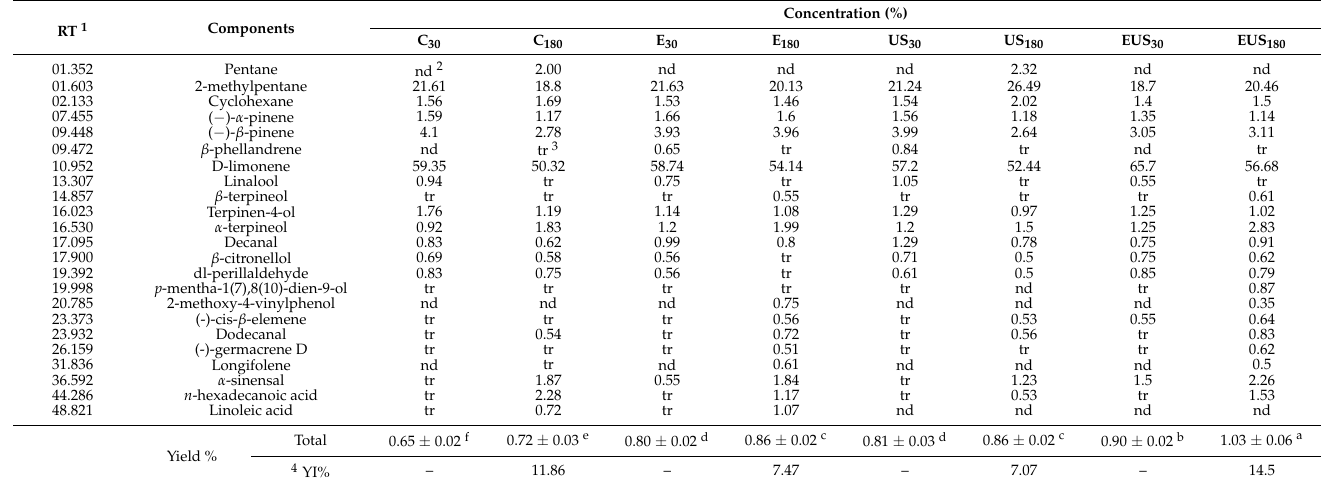
Table 2. Chemical composition of the CrBL-EO